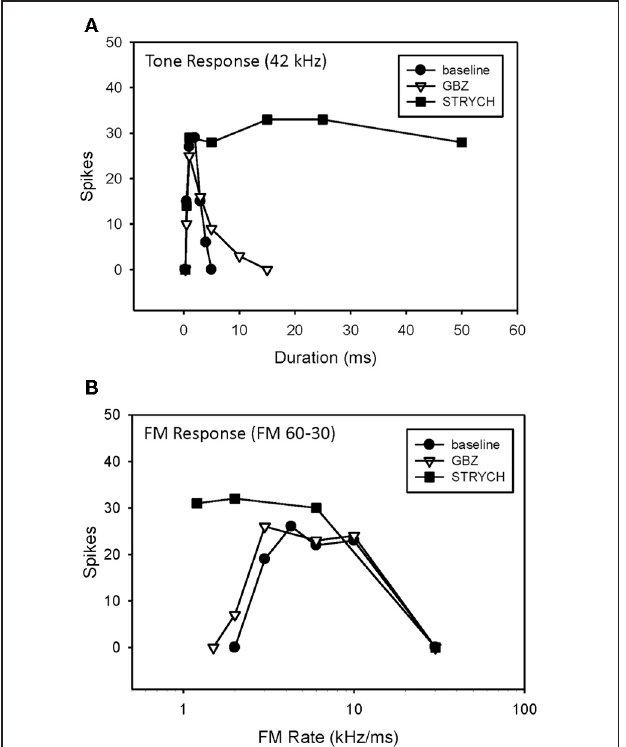
FIGURE 6 | Conversion of duration tuning (A) and FM rate selectivity (B) from bandpass to slowpass following application of STRYCH. GBZ had no effect on either parameter.